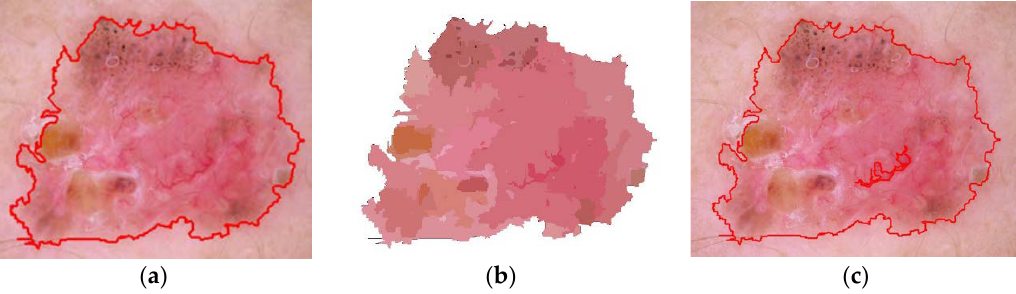
Figure 6. ( a ) ELM image and lesion contour; ( b ) statistical region merging (SRM) segmentation of the lesion area; ( c ) automatic detection of AVP.